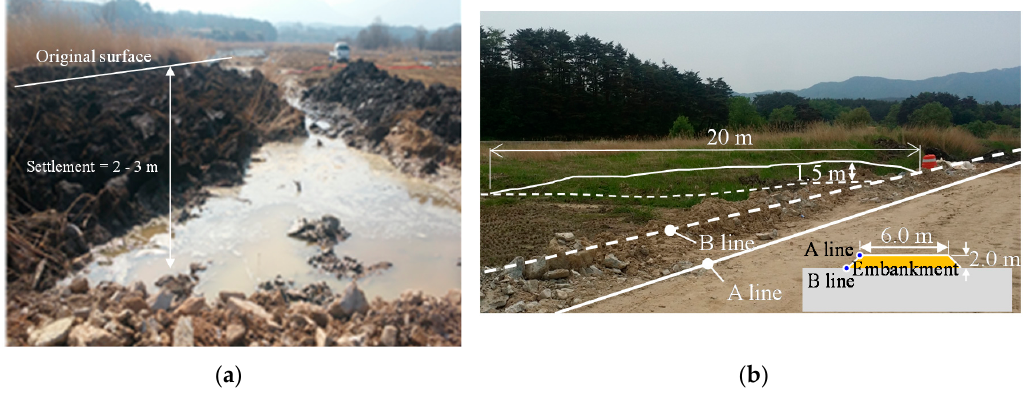
Figure 5. Field investigations: ( a ) Settlement; ( b ) range and height of heave soil.